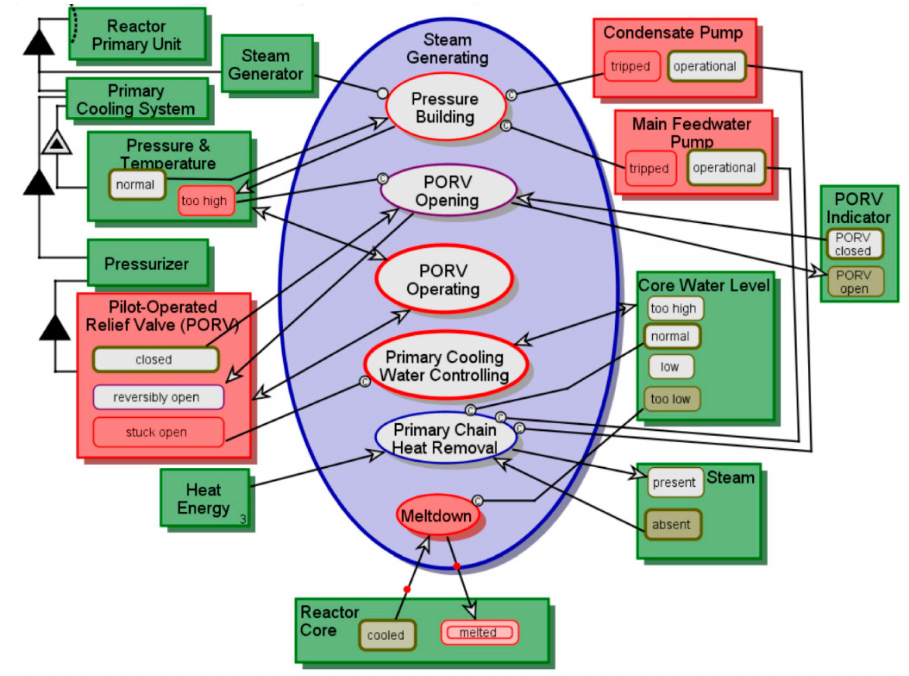
Figure 12. Steam Generating—Meltdown—CPG-Aware